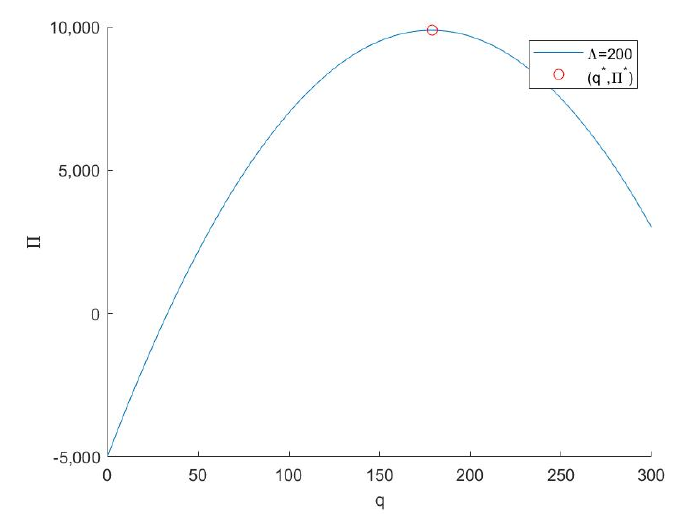
Figure 2. Advertisement design strategy of advertisers on video platforms. Note: U 0 = 100, t 1 = 100, t 2 = 20, l = 600, β = 0.1, C a = 5000, k = 1, ρ = 1, τ = 1.